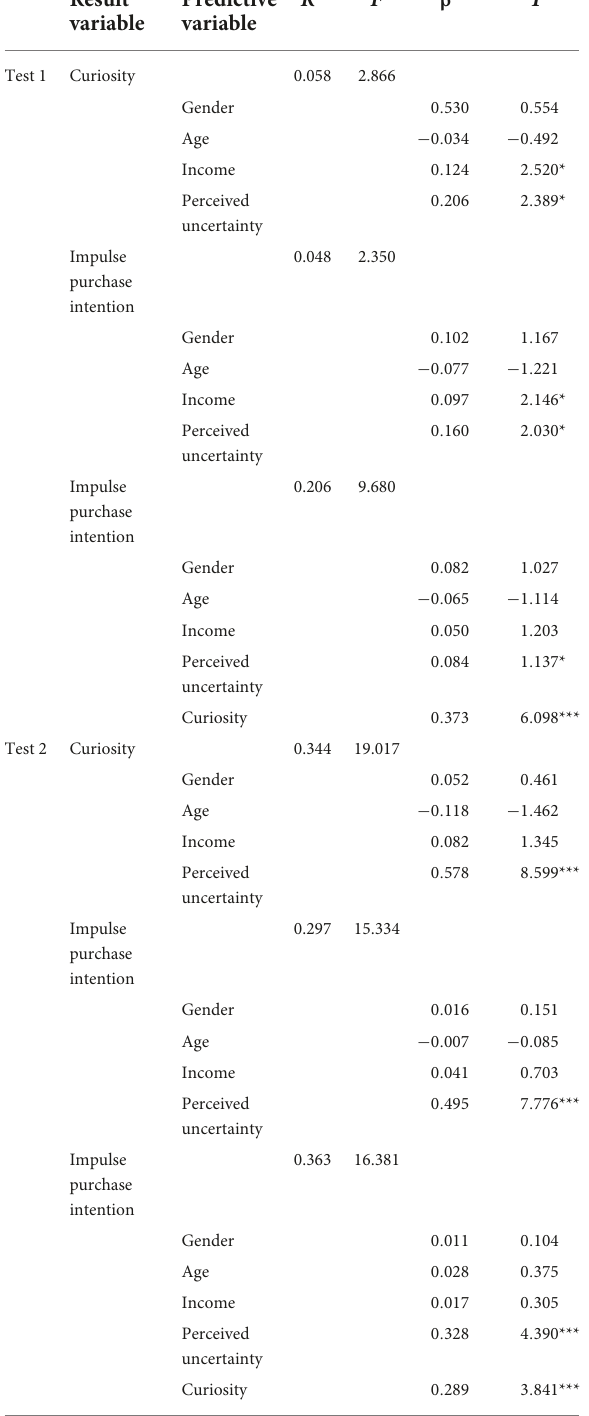
TABLE 10 The robustness test of the mediating effect of